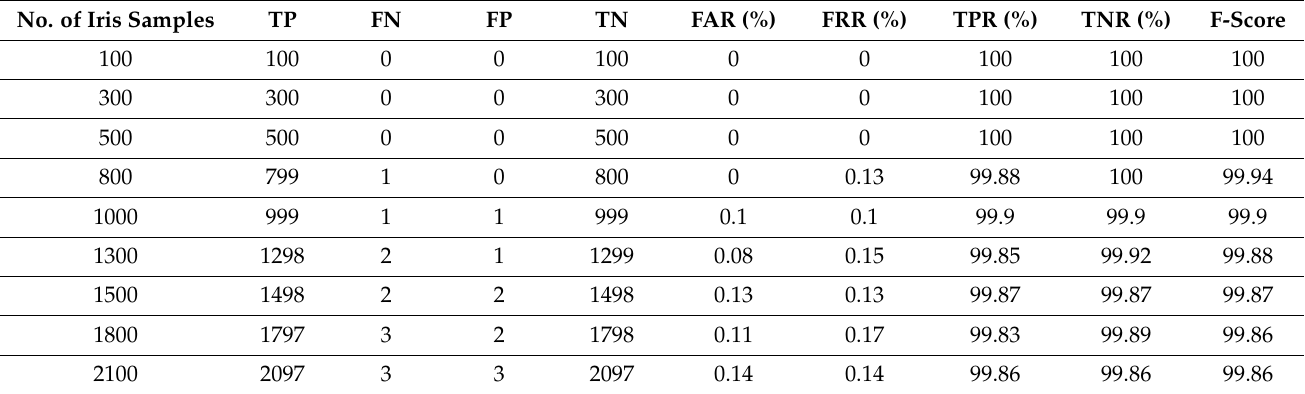
Table 1. Performance evaluation of cancelable approaches (HGLD, signcryption) on the CASIA iris